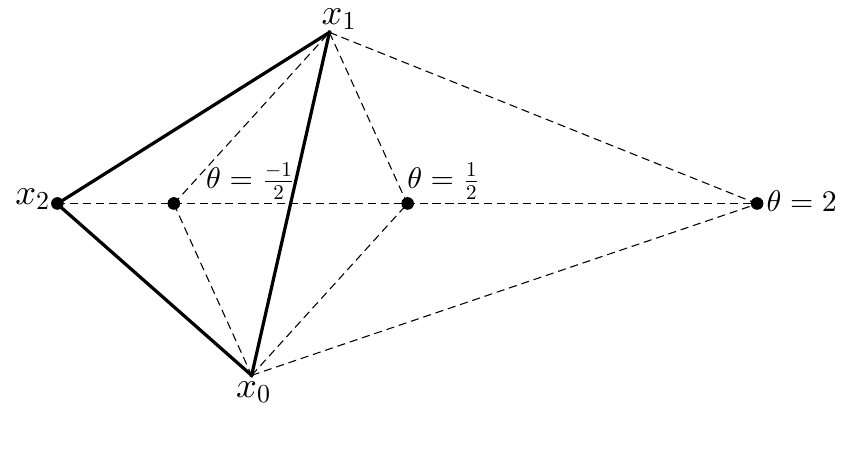
Figure A2. Illustration of the Nelder–Mead method. The points x 0 , x 1 and x 2 form the initial simplex. The vertex x 2 is replaced with a vertex of the form x new = ¯ x + θ ( ¯ x − x 2 ) . If f ( ˆ x ) < f ( x 0 ) , θ =